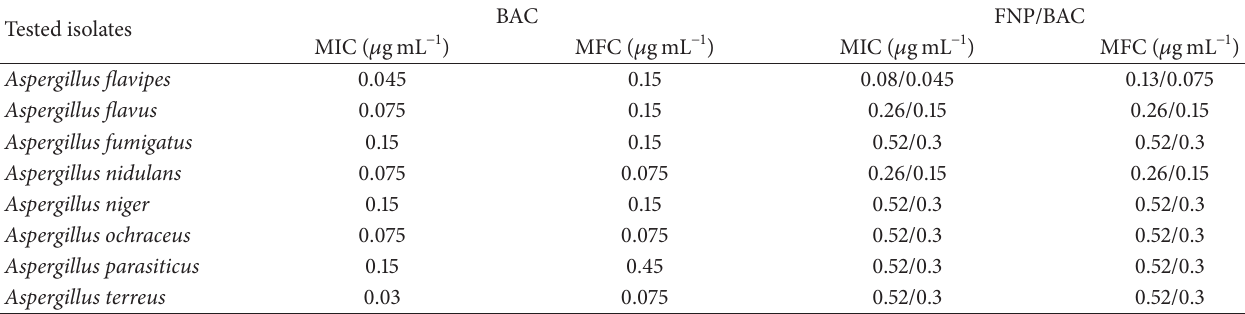
Table 1: Minimum inhibitory concentration (MIC) and minimum fungicidal concentration (MFC) for benzalkonium chloride (BAC) and fullerenol/benzalkonium chloride nanocomposite (FNP/BAC) obtained in microdilution method. Tested